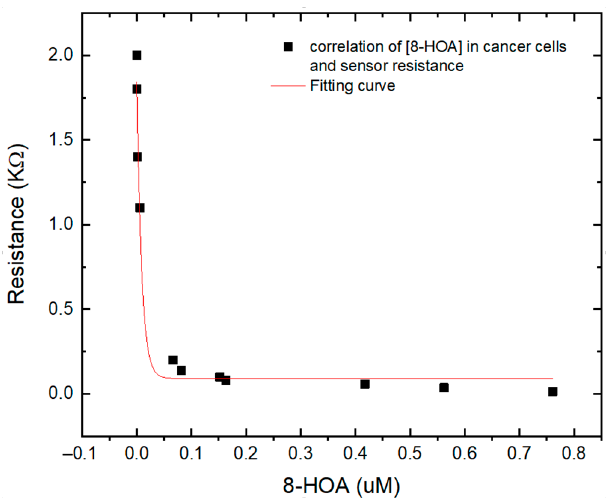
Figure 8. Correlation between different concentration of 8-HOA detected by gas chromatography– mass spectroscopy (GC–MS) and resistance measured by Ti 3 C 2 MXene sensor using the same sampling conditions.